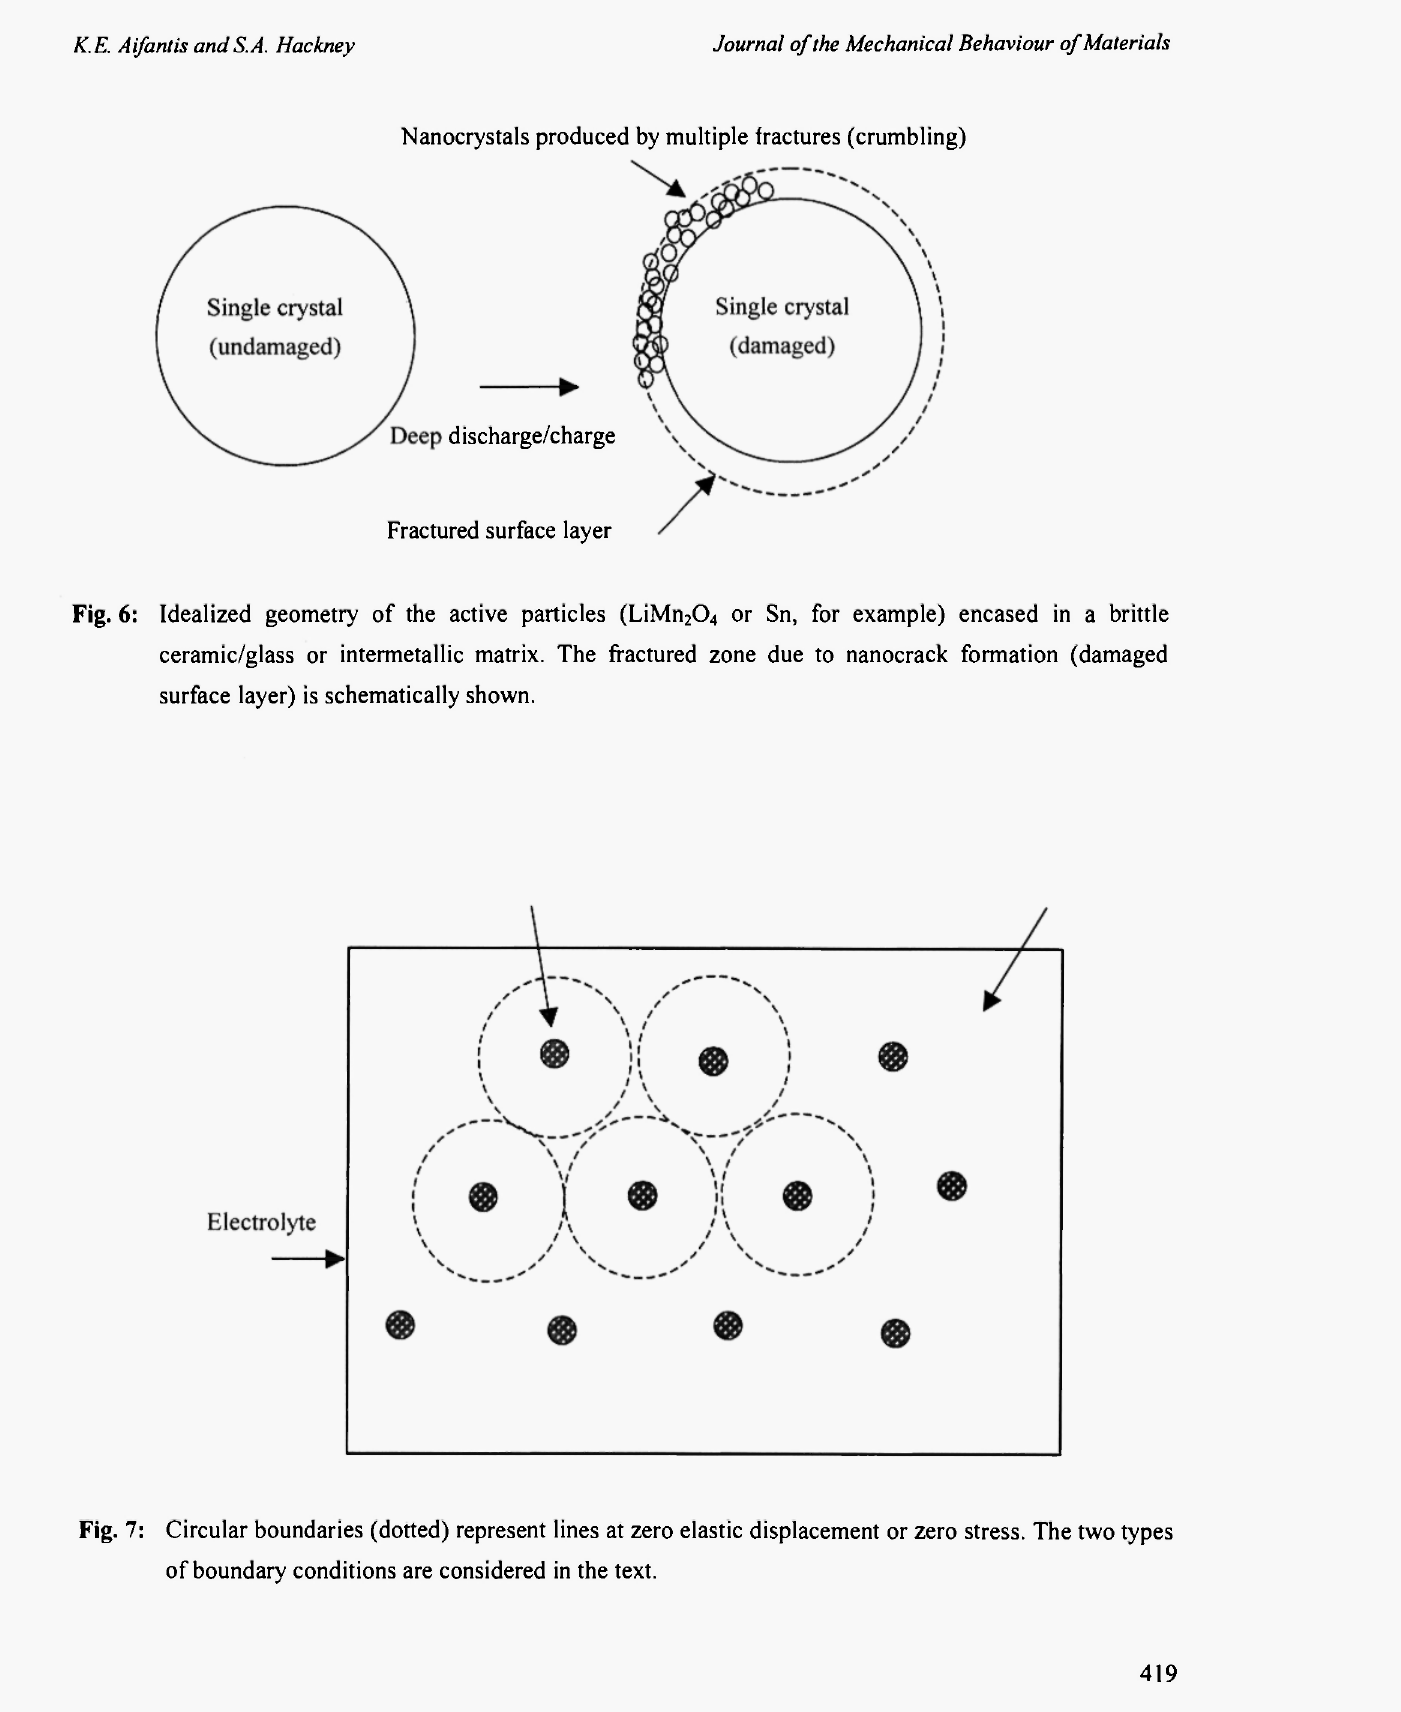
Fig. 7: Circular boundaries (dotted) represent lines at zero elastic displacement or zero stress. The two types of boundary conditions are considered in the